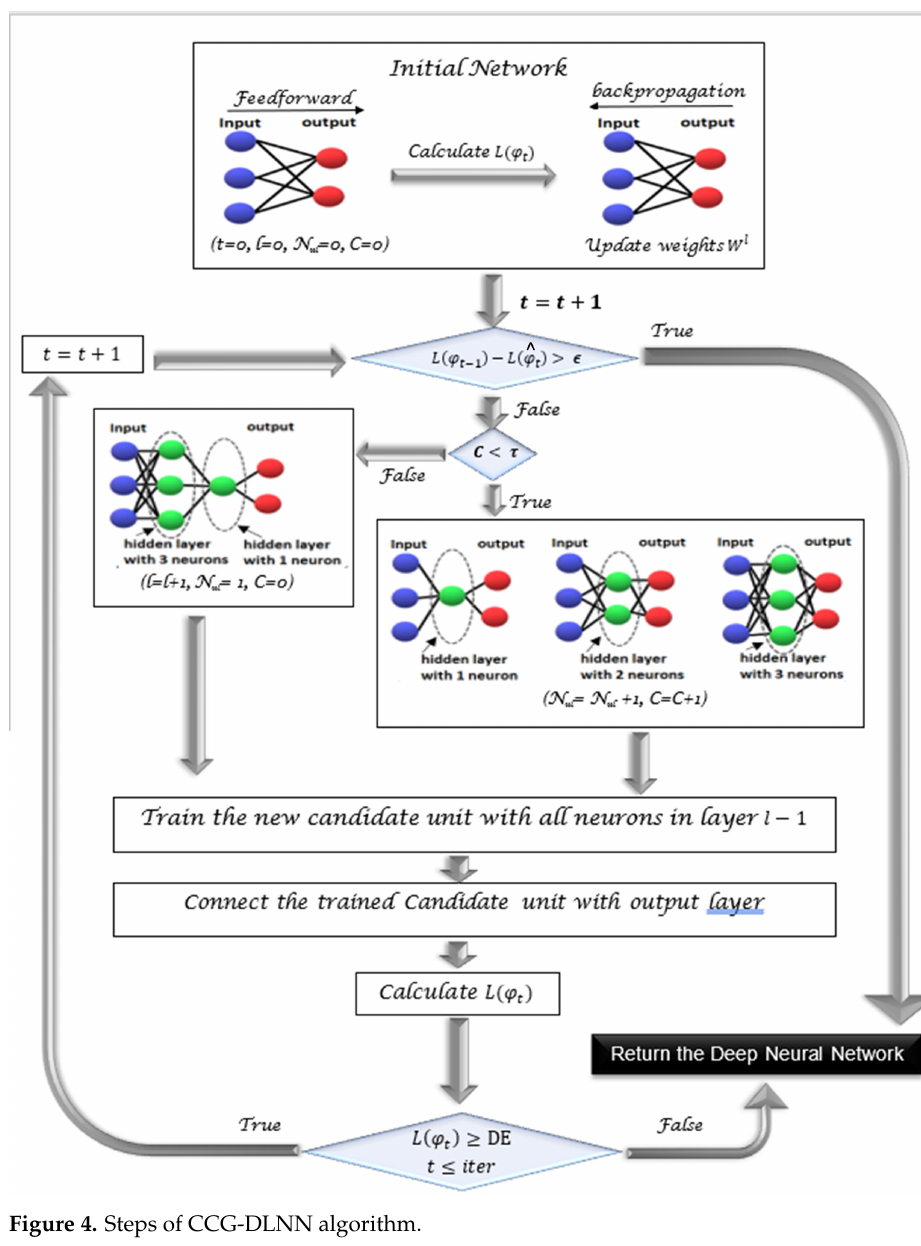
Figure 4. Steps of CCG-DLNN algorithm.